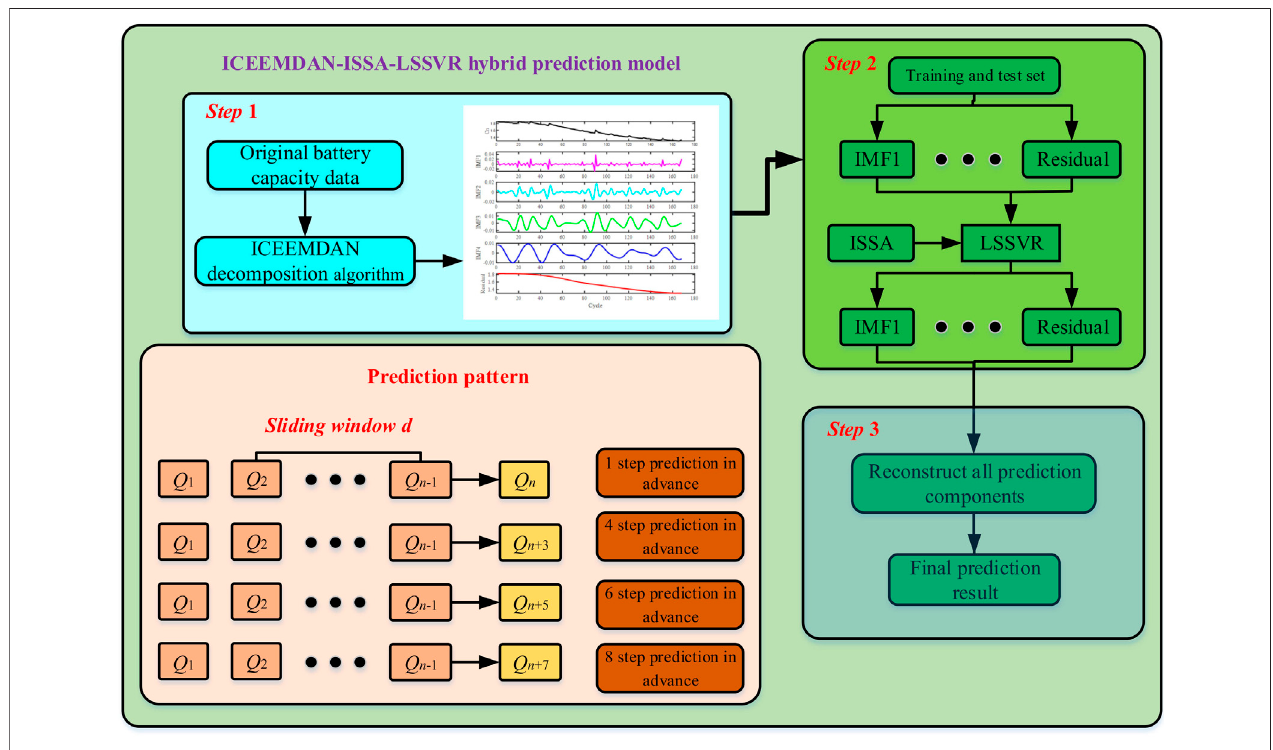
FIGURE 1 | Detailed prediction